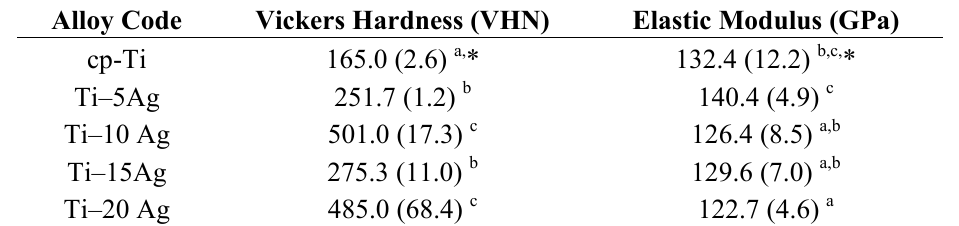
Table 1. Vickers hardness and elastic modulus values of Ti– x Ag alloys compared to cp-Ti ( n =